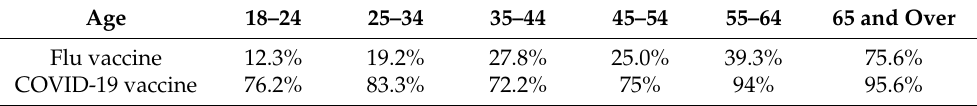
Table 6. Comparison between vaccination for influenza and COVID-19 by age group in